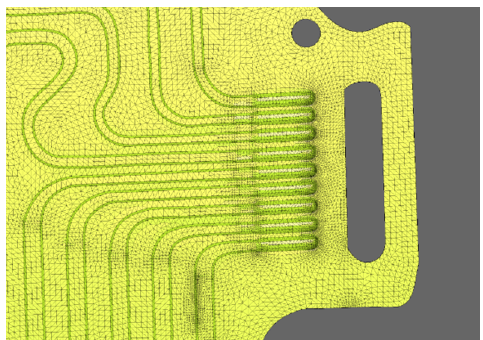
Figure 4. MeshWorks 8.0 screenshot during meshing of cooling plate.